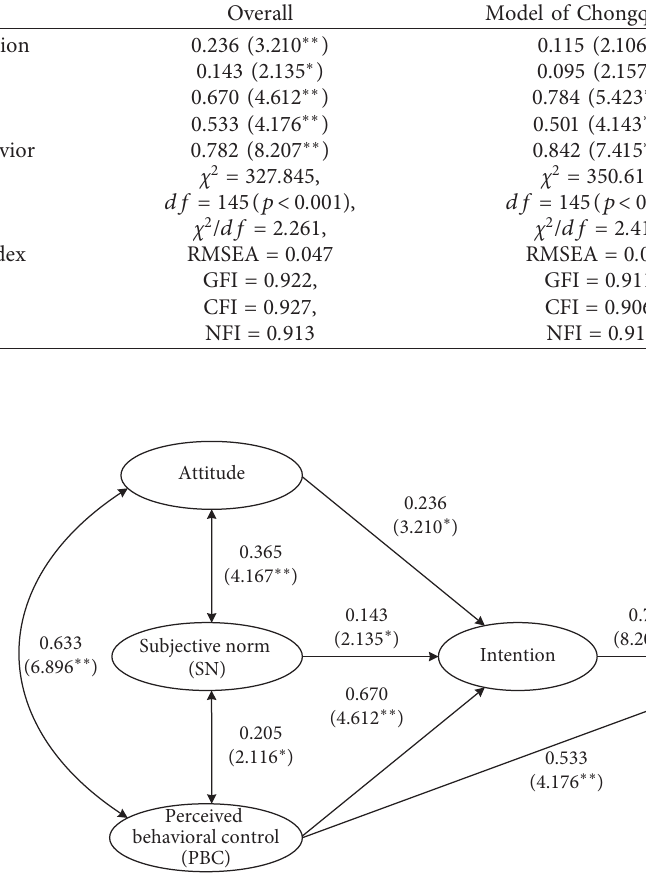
Figure 2: Estimated model of Chongqing and Chengdu.